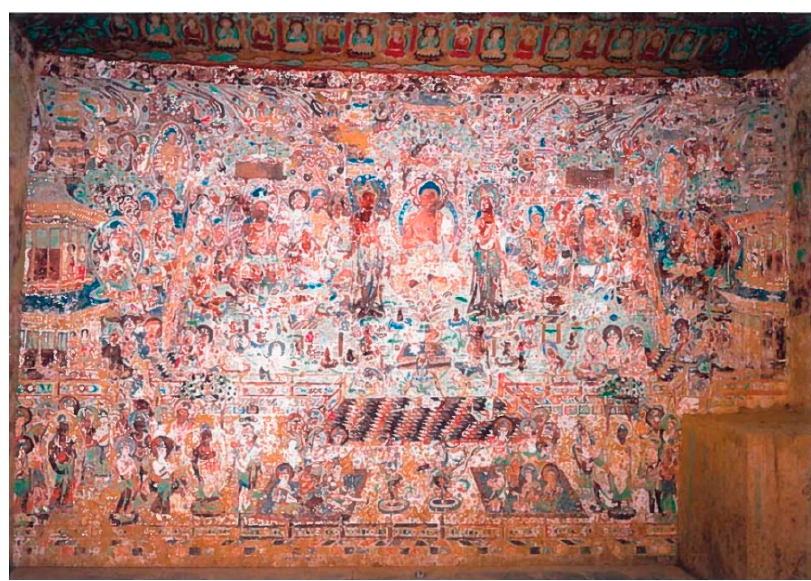
Figure 8. Western Pure Land, South Wall, Dunhuang Cave 220, Early Tang (Xiao 1989). The West Pure Land of the Amitayurdhyana sutra on the north wall of Cave 217 is representative of all transitions during the high-Tang period. All figures in the composition, including architectural elements, are confined to the front of the rear edge of the lotus pool. Many buildings of varying forms are placed on level ground to the rear of the jeweled pool in front of which the Buddha and attendants are placed. The buildings are divided into two types: individual buildings, including a central front hall and four pairs of tall towers; and a rear building complex consisting of a central hall of three bays square with a hip-gable roof, flanked by twin-wing roofed corridors on both sides (Figure 9).